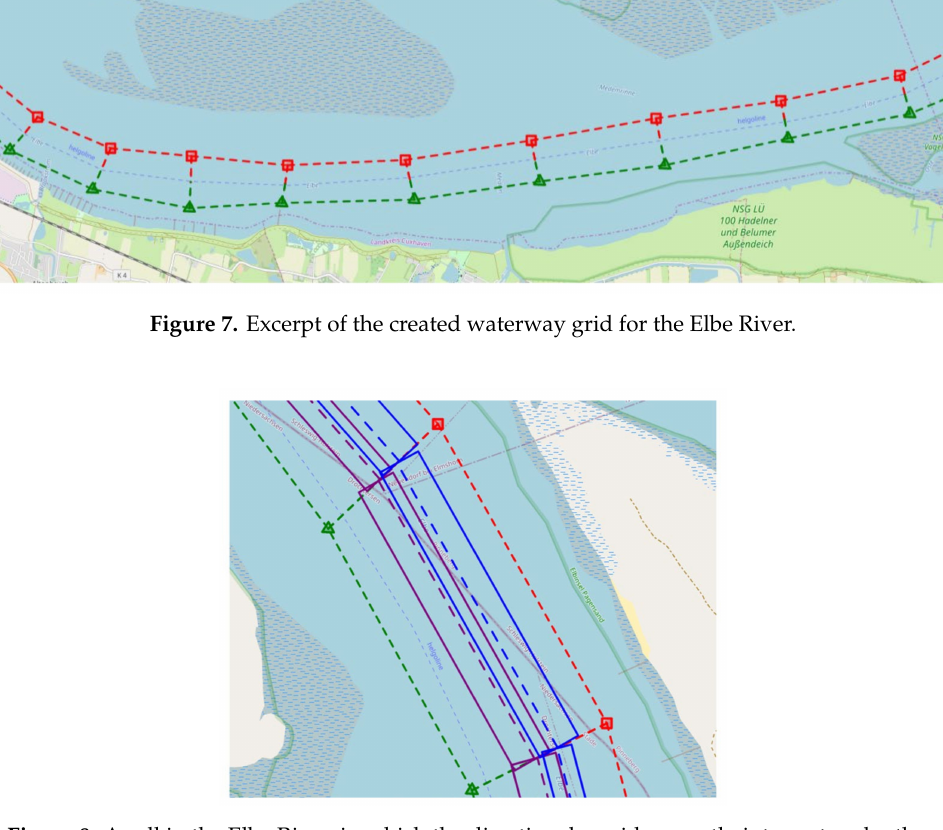
Figure 8. A cell in the Elbe River, in which the directional corridors partly intersect each other.